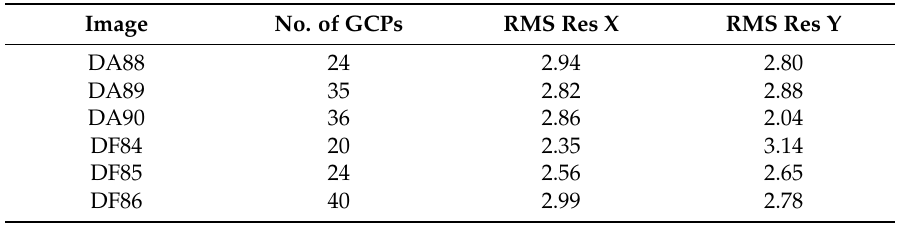
Table 2. Geometric parameter adjustment results for absolute orientation. x, parallax across flight direction; y, parallax in flight